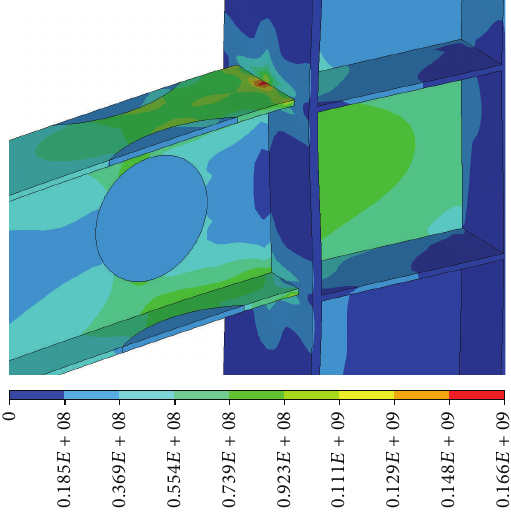
Figure 24: Stress of frame with replaceable connection 4.